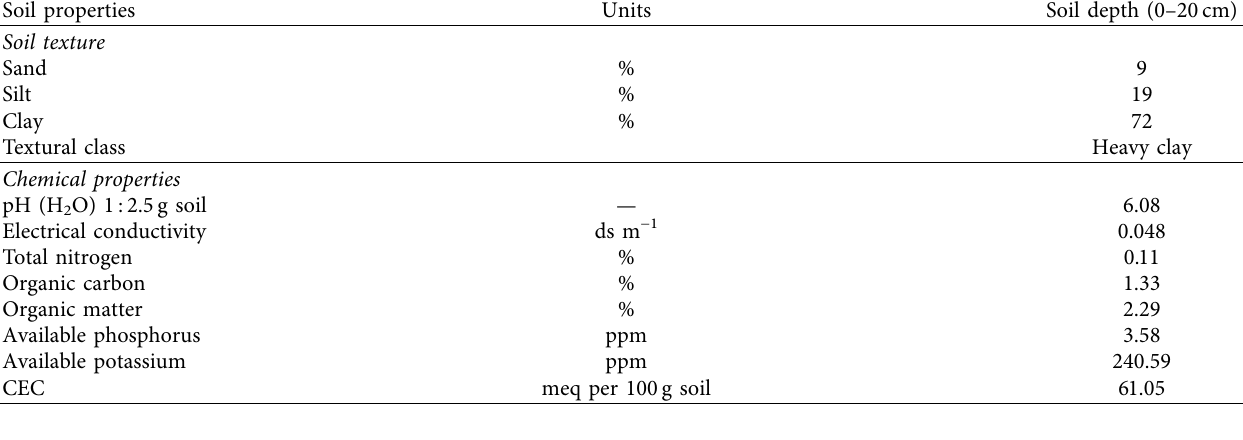
Table 1: Selected physical and chemical properties of the soil of the experimental site.